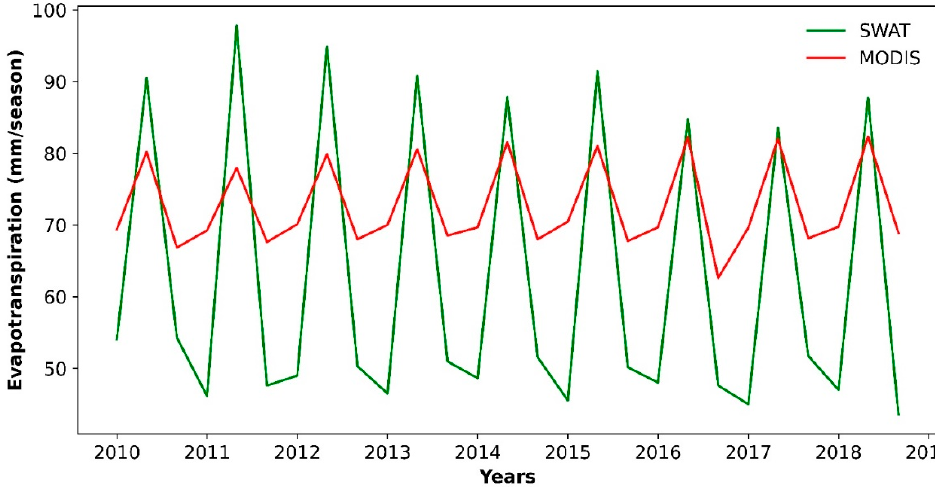
Figure 9. Comparison of seasonal SWAT-simulated and MODIS evapotranspiration data. For MODIS, the maximum and minimum values of seasonal ET were 82.3 mm (13% greater than mean seasonal ET) and 62.6 mm (14% less than mean seasonal ET), respectively. On the other hand, for SWAT-simulated seasonal ET, the maximum and minimum values of seasonal ET were 97.8 mm (56% greater than mean seasonal ET) and 43.6 mm (30% less than mean seasonal ET), respectively.